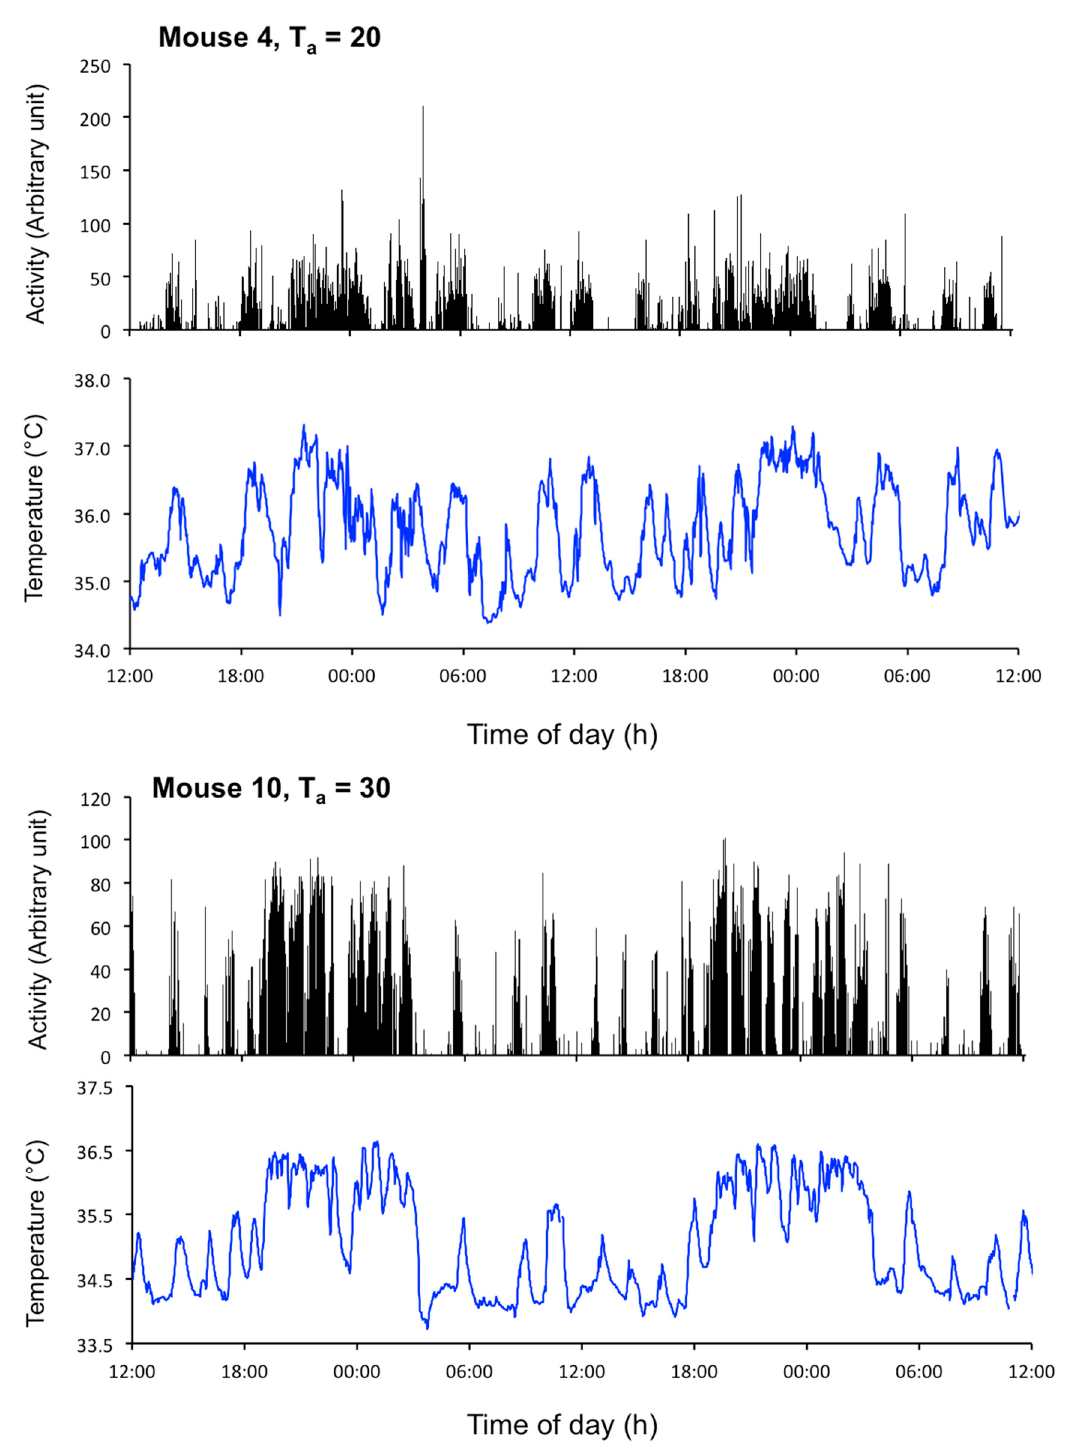
Figure 4. Profiles of activity and body temperature in a mouse kept at an ambient temperature of 20 °C (top two panels) or 30 °C (bottom two panels) to illustrate the synchrony between the EUEs of temperature and the EUEs of activity [79] NB: It has been demonstrated that the EUEs of temperature precede the EUEs of activity [80].